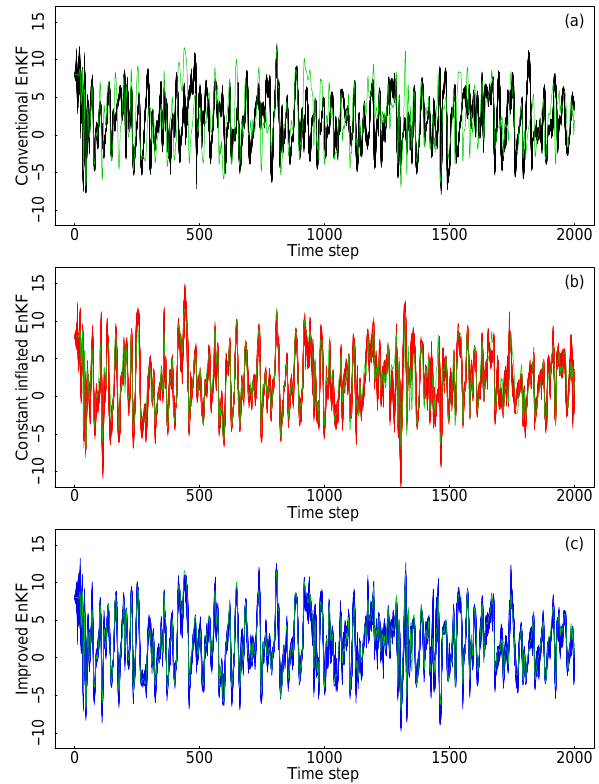
Figure 7. Ensemble analysis state members of the conventional EnKF (black line), the constant inflated EnKF (red line) and the improved EnKF (blue line) for the Lorenz-96 experiment with 40- observation and 30-ensemble member. The constant multiplicative inflation factor is set as 1.88. The green line refers to the true trajec- tory obtained by the numerical